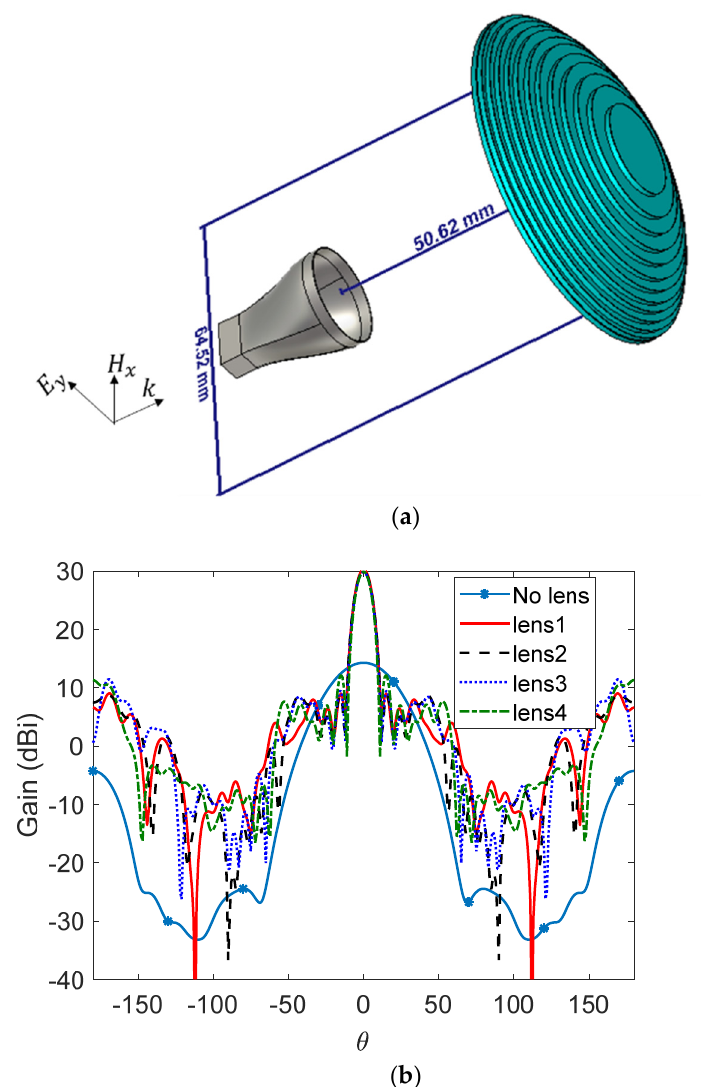
Figure 4. ( a ) The designed lens 2 with the horn antenna. ( b ) The co-polarized radiation pattern of the horn antenna with and without a dielectric slabs-based lens using the finite integration technique (FIT) solvers in CST. The aperture area of the designed lens is a = 64.52 mm, and the horn antenna is placed at the optimized focal point ( f = 50.62